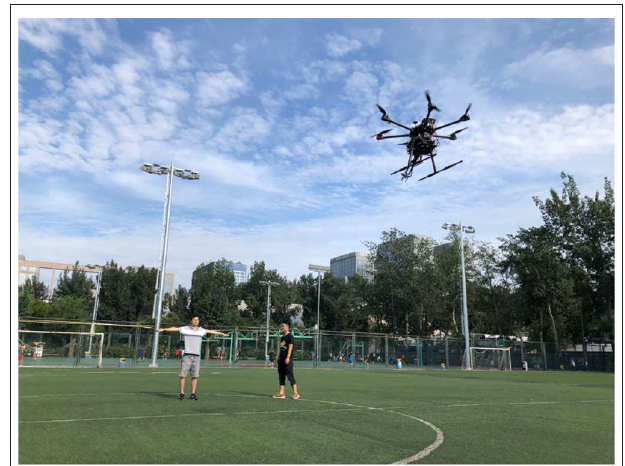
FIGURE 8 | Prototype of the proposed interactive UAV.